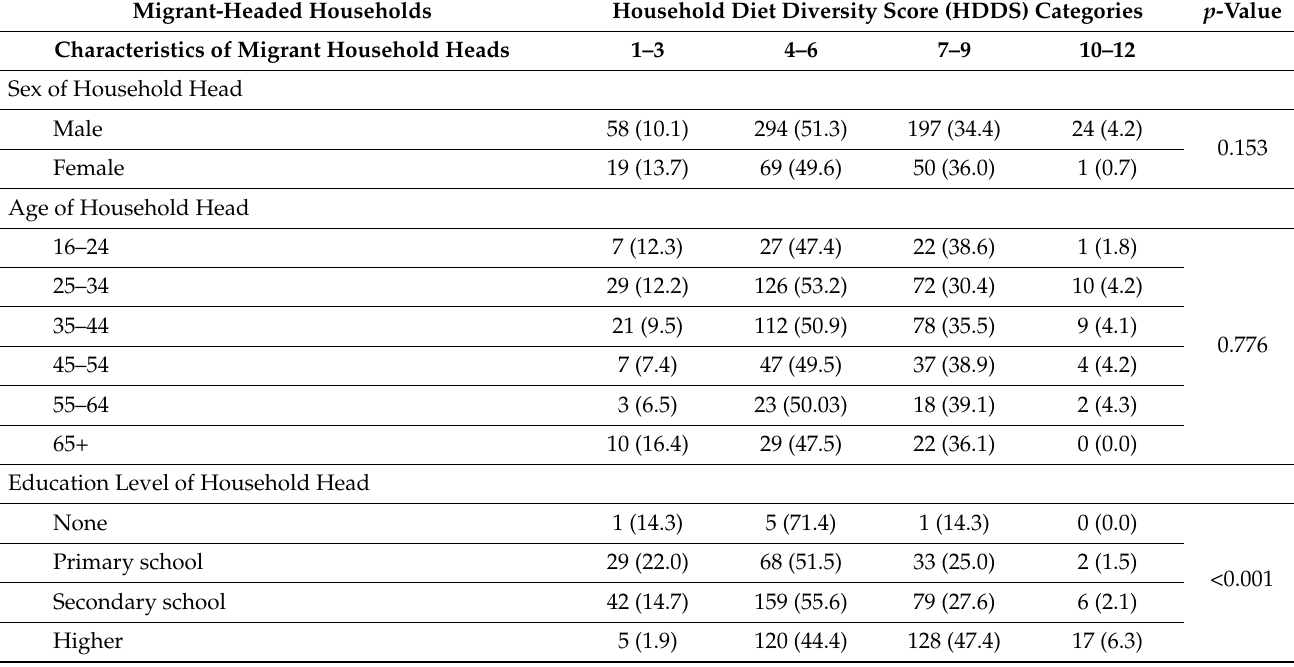
Table 7. Migrant household characteristics and dietary